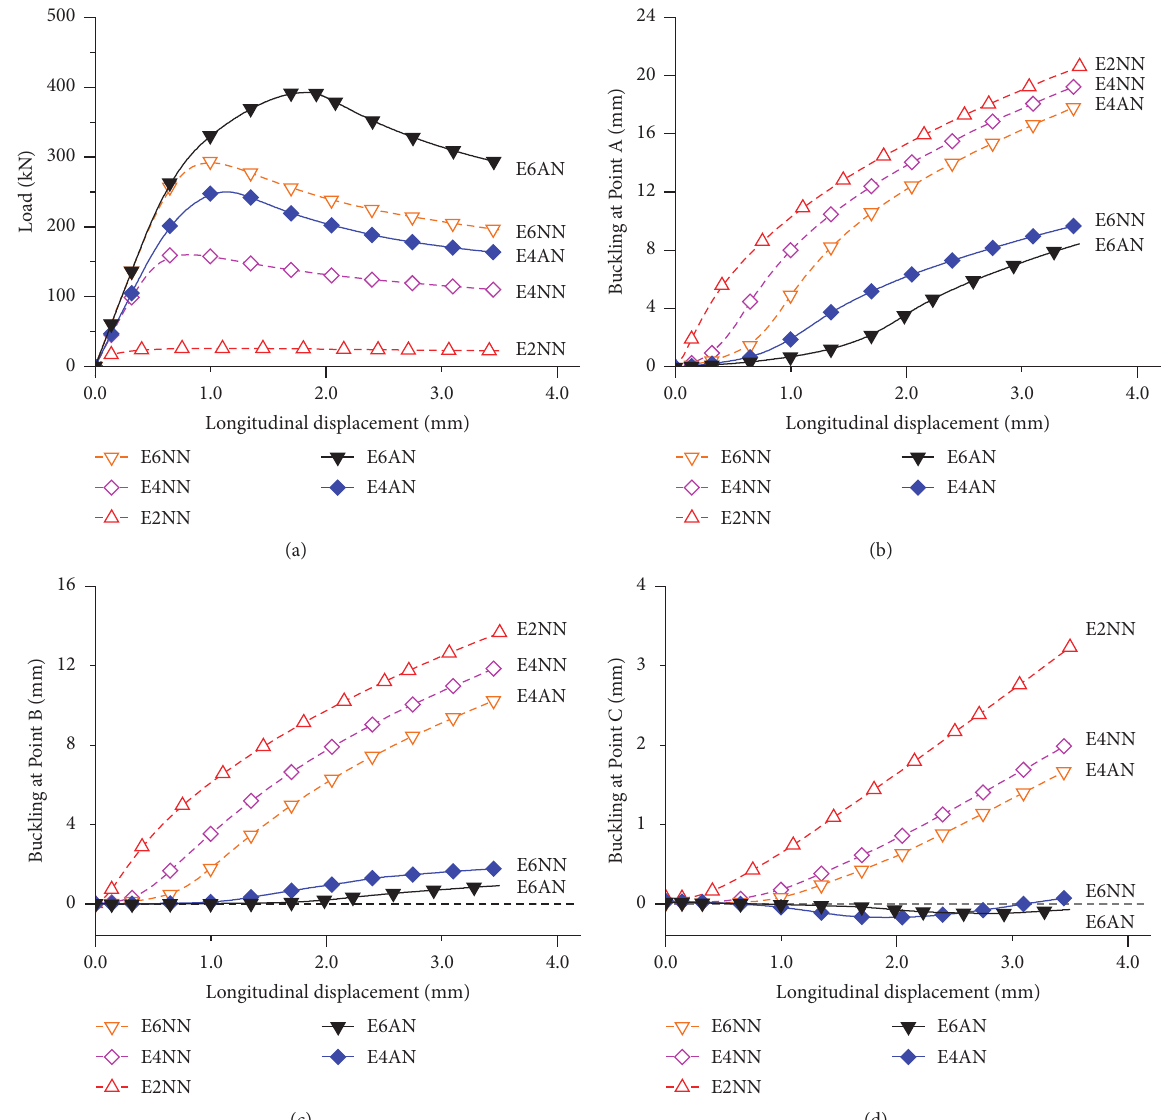
Figure 8: Load-displacement and buckling-displacement curves 1: (a) load-displacement curves; buckling-displacement curves at (b) Point A, (c) Point B, and (d) Point